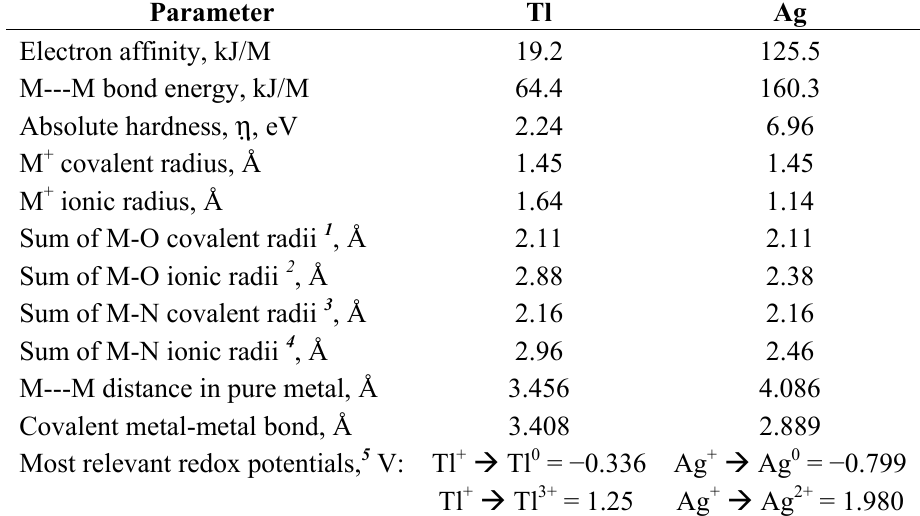
Table 1. Physical and chemical data for thallium, silver and their monovalent